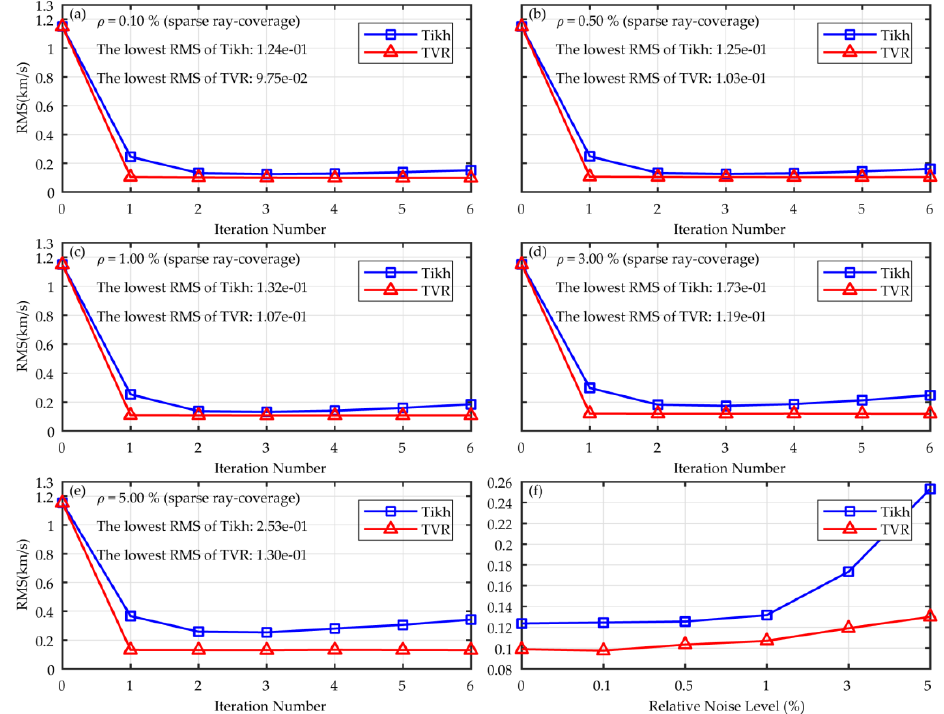
Figure 15. ( a – e ) the convergence curve of RMS for velocity solved with noised T under the sparse ray-coverage case. The RNL of ( a – e ) respectively is 0.1%, 0.5%, 1.0%, 3.0%, 5.0%; ( f ) the comparison of RMS of velocity among the inversion results under different relative noise level. The blue points are the results solved with Tikh, and the red points are the results solved with TVR. The RNL and lowest RMS of the results solved by the Tikh and TVR are marked on ( a – e ).